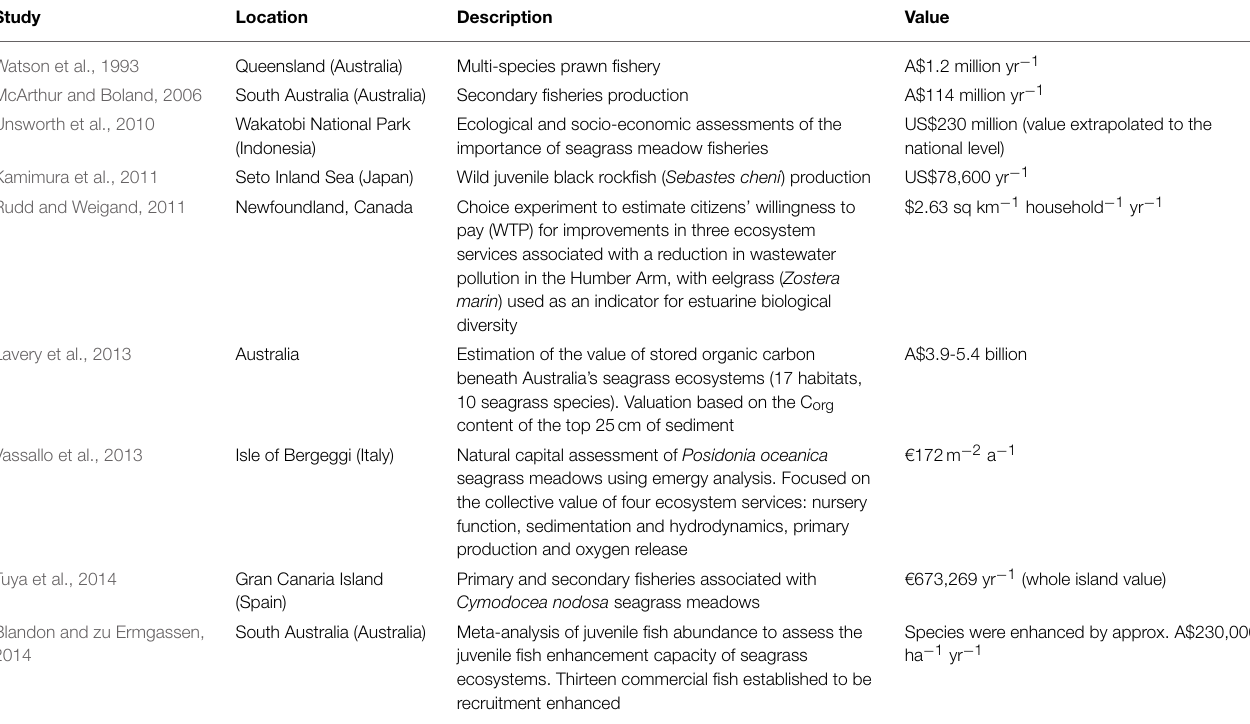
TABLE 2 | Valuation studies of seagrass